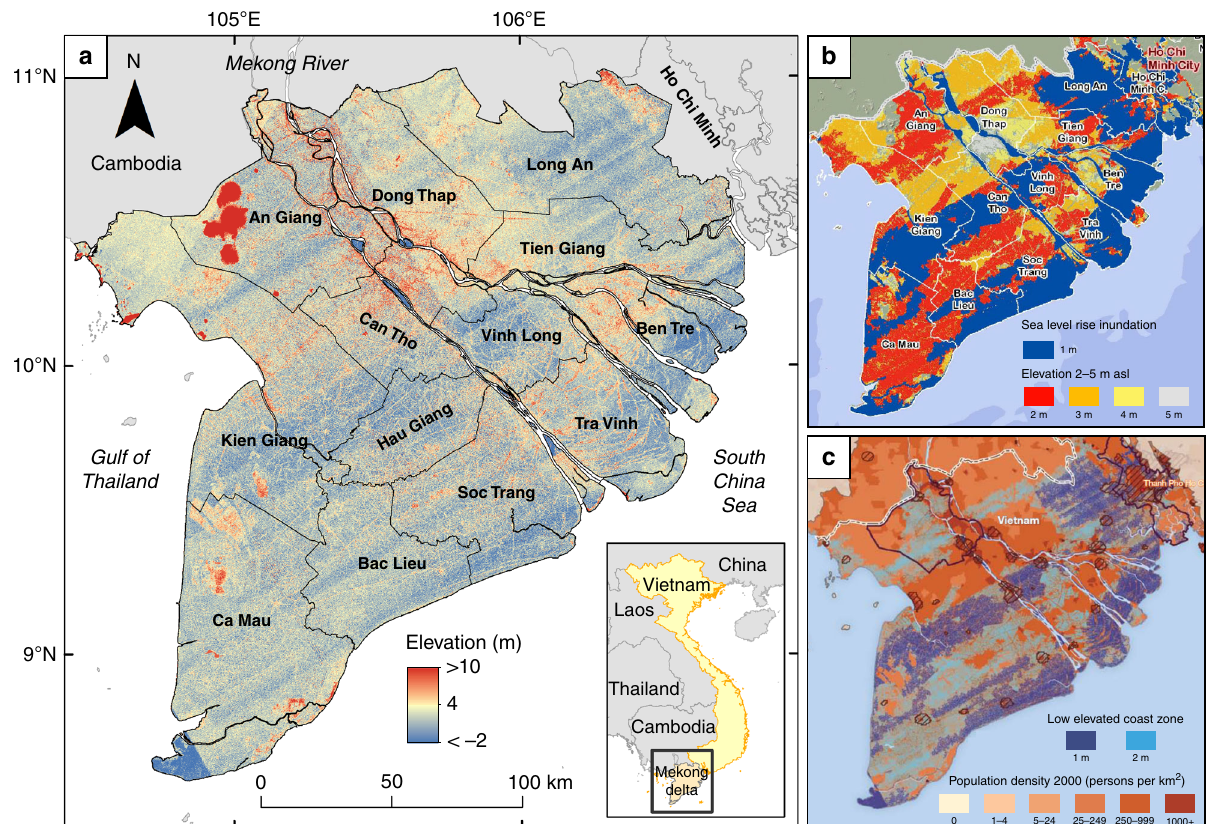
Fig. 1 Spaceborne elevation of the Mekong delta and derived inundation maps. a Shuttle Radar Topography Mission (SRTM) Digital Elevation Model (DEM) of the Mekong delta in Vietnam. b , c Inundation maps following sea-level rise based on the SRTM DEM containing effects of striping and other height errors . b Inundation zones with meters sea-level rise 29 , copyright by 2008 ICEM. Used by written permission. This map was included in several policy documents, amongst others, the Asian Development Bank 36 , Mekong River commission technical paper 32 ; World Wildlife fund risk assessment Mekong 34 and the Dutch-Vietnamese Mekong Delta Plan 35 , which is now a leading document for major Worldbank projects in the delta. c Low elevated coast zones with population density 30,38 , copyright by 2008 CARE International and UN University. Used by permission. This map was included in, amongst others, the risk assessment Mekong by the World Wildlife Fund